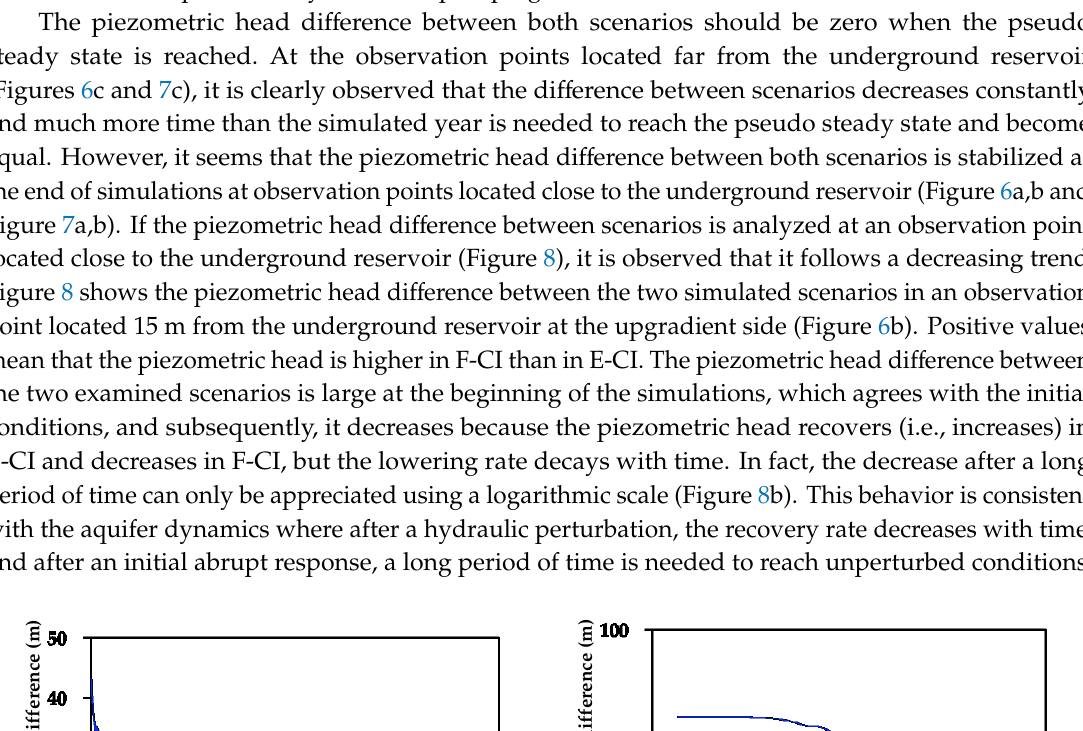
( b ) Figure 9. Hydraulic head evolution inside the chambers for scenarios ( a ) F-CI and ( b ) E-CI. The hydraulic head evolves equally in chambers CH1 to CH3 (except at the beginning of E-CI) because pumping is not allowed when the volume of water inside the underground reservoir is lower than the 10% of its maximum capacity. Consequently, the minimum hydraulic head reached during pumping periods is about 43 m, which is higher than the elevation of the bottoms of CH1, CH2 and